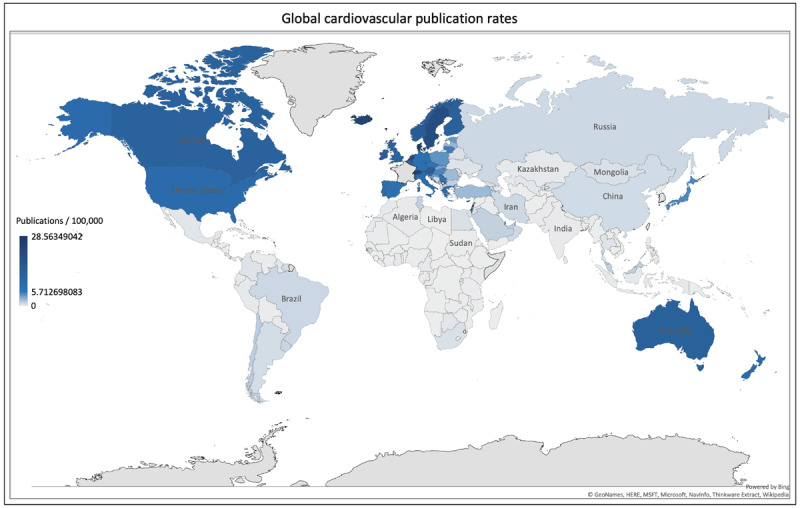
Hover over heat-map showing publication rates per 100,000 population based on integer counts (attached).